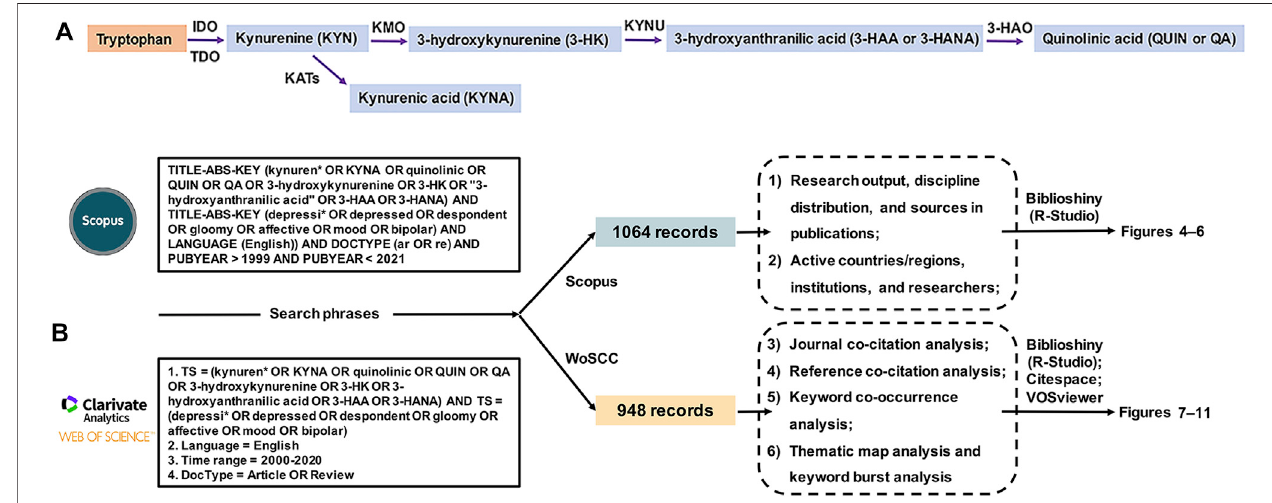
FIGURE 3 | (A) The kynurenine pathway (KP) (B) The bibliometric analysis work fl ow, including detailed information on search phrases used in the Scopus and WoSCC databases, along with the corresponding numbers of extracted records, bibliometric analysis items, analysis tools, and generated fi gures. Note. IDO: indoleamine 2,3-dioxygenase, TDO: tryptophan dioxygenase, KATs: kynurenine aminotransferases, KYN: kynurenine, KYNA: kynurenic acid, KMO: kynurenine-3- monooxygenase, 3-HK: 3-hydroxykynurenine, KYNU: kynureninase, 3-HAA or 3-HANA: 3-hydroxyanthranilic acid, 3-HAO: 3-hydroxyanthranlic acid oxygenase, QUIN or QA: quinolinic